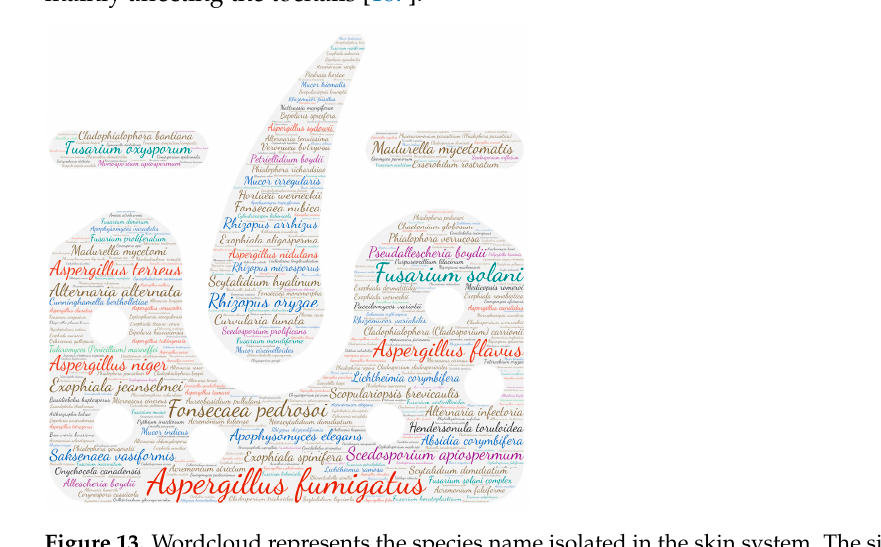
Figure 13. Wordcloud represents the species name isolated in the skin system. The size of the name of each species is proportional to the number of times it occurs in the